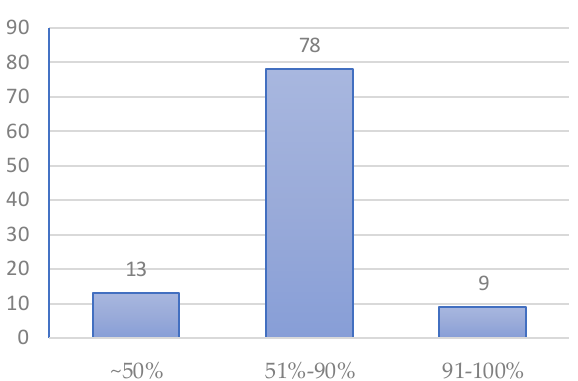
Figure 3. The percentage of key ingredients in Thai cuisine that respondents are able to use in their own cooking. In total, 78 out of 100 respondents report being able to competently cook with more than half (51–90%) of everyday Thai ingredients, which facilitates economical food planning.